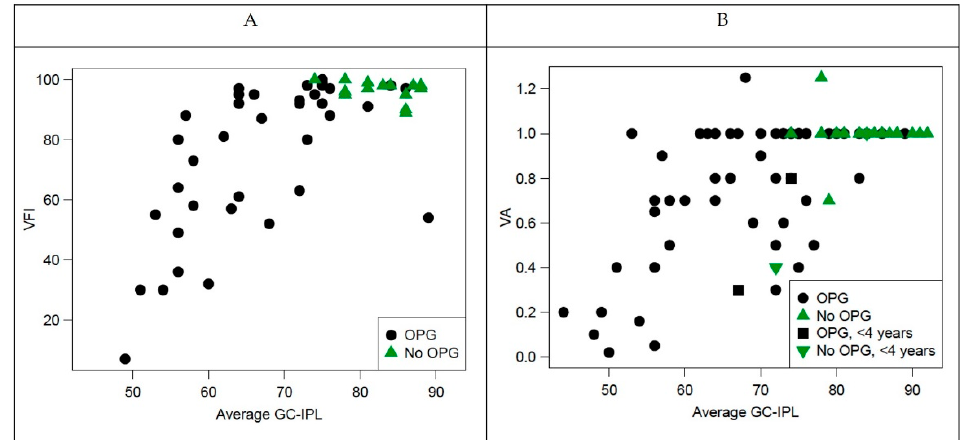
Figure 5. Correlation between visual function (visual field index and visual acuity and structure (average ganglion cell ‐ internal plexiform layer [GC ‐ IPL]). (A) Visual field index plotted against average GC ‐ IPL; ( B ) visual acuity plotted against average GC ‐ IPL. OPG—optic pathway glioma; VFI—visual field index.